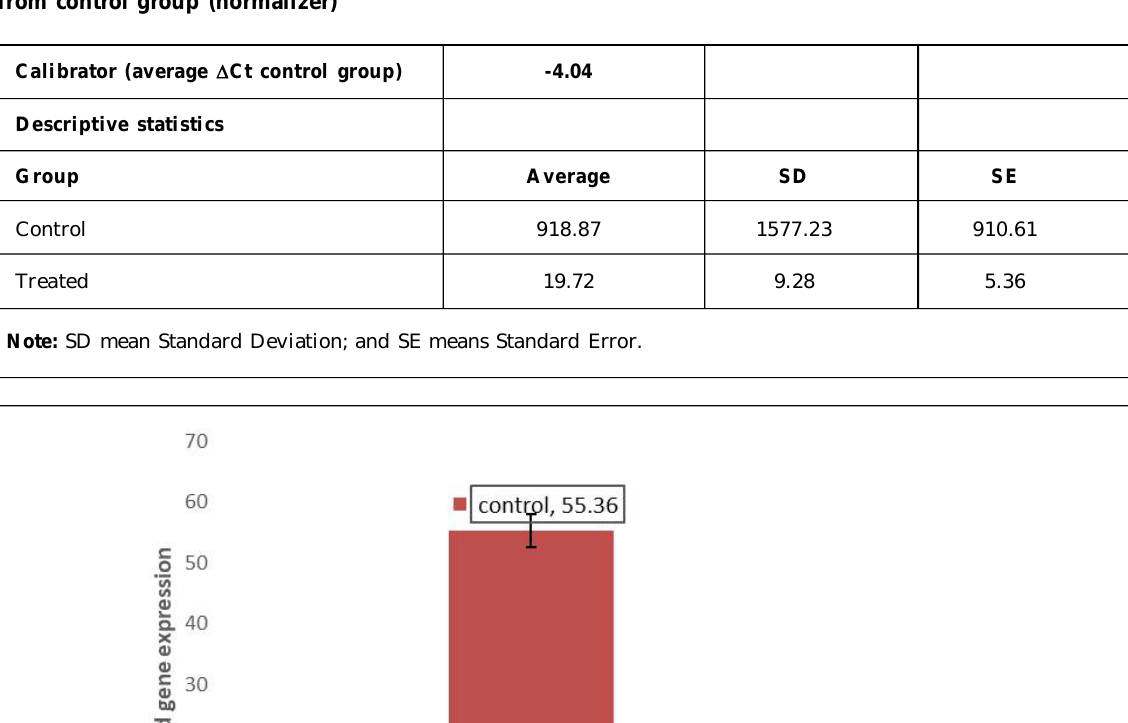
Table 6: Descriptive analysis for  ct value of LmcesA20 in each sample average value of calibrator generated from control group (normalizer)